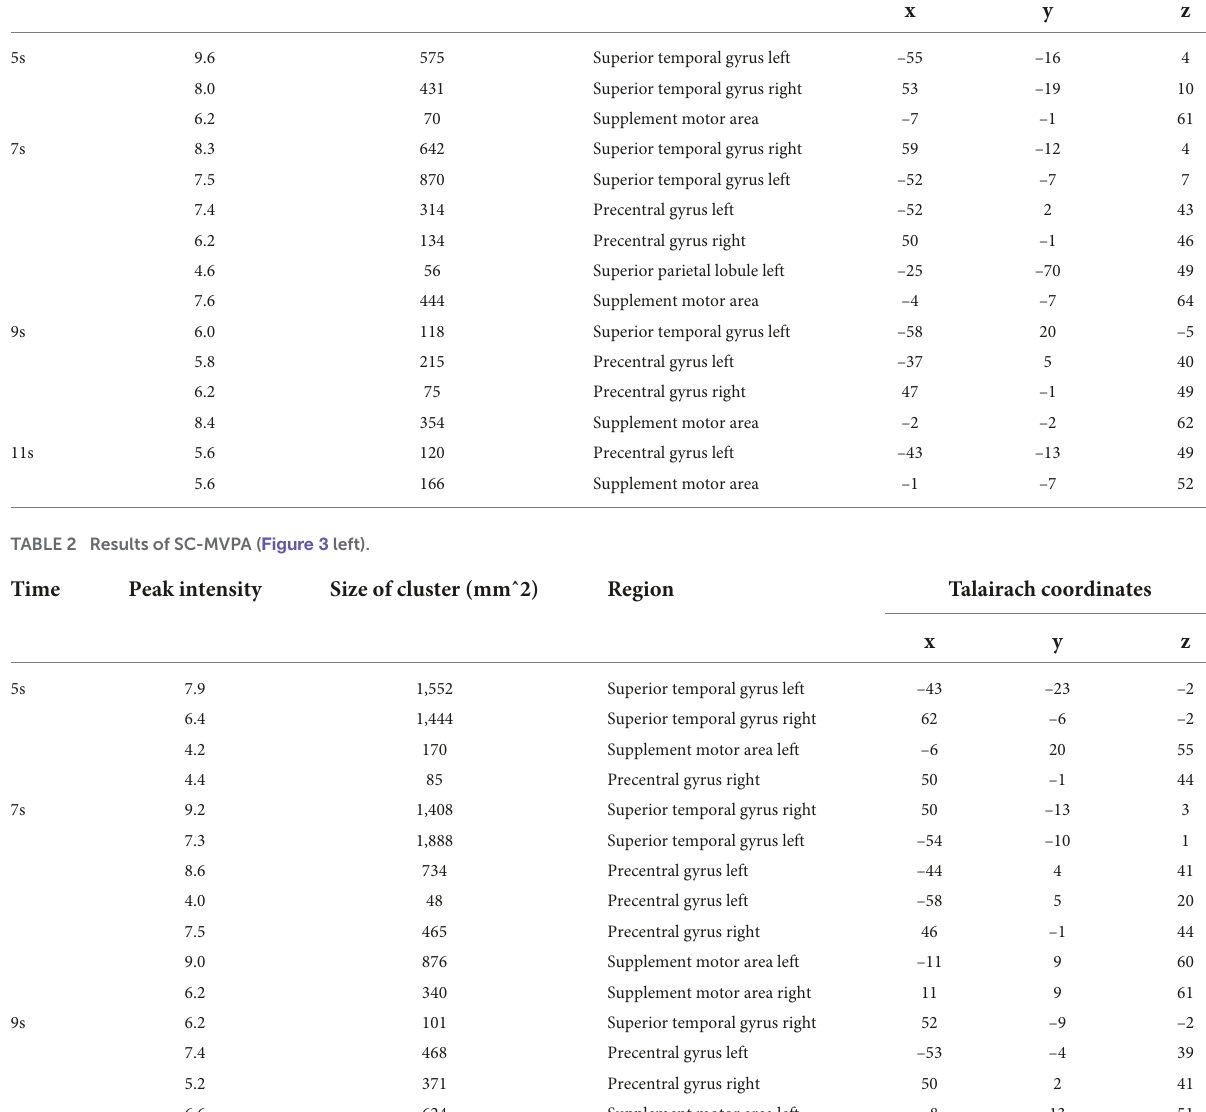
TABLE 1 Results of volume space based MVPA ( Figure 3 right). Time